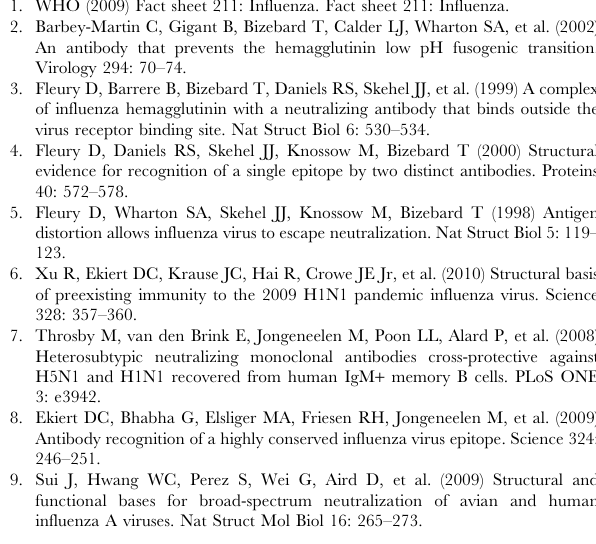
Figure S3 Virus challenge strain–specific HAI, VNA and ADCC titers remain constant after first immunization. HAI, VNA and ADCC titers against ( A ) H1N1 A/California/07/ 2009 and ( B ) H5N1 A/Hong Kong/156/97 are depicted for pre- vaccination serum and sera obtained after 1 6 , 2 6 , and 3 6 vaccinations. Dashed lines indicate background levels in the respective assays. The titers at all three post-vaccination visits are statistically significantly higher (p , 0.001) than at the pre- vaccination visit for all assays except for HAI H5N1 where all titers fall below the detection limit.